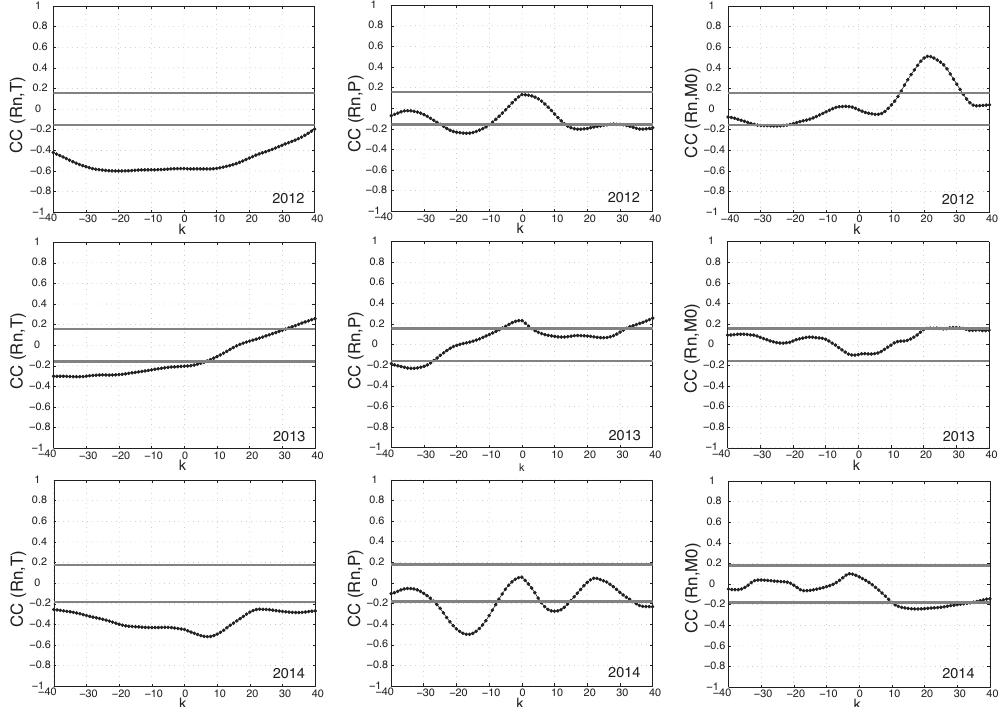
Figure 6. Cross-correlation function (CC) evaluated for 2012–2013–2014 separately, between radon concentration Rn and temperature T , pressure P and seismic moment release M 0 . The CC is evaluated between 14-day moving average filtered time series. Horizontal gray lines represent 99% confidence threshold.